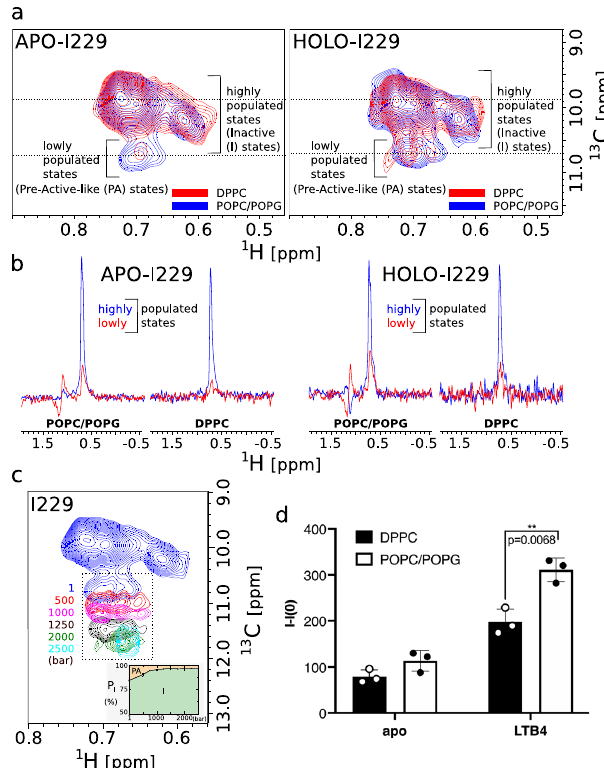
Fig. 6 Impact of the lipid phase on BLT2 activation. a Close-ups in the δ 13 CH 6.40 region of two superimposed 1 H, 13 C SOFAST-HMQC 3 - 1 -I229 experiments were recorded at atmospheric pressure with apo (left) and holo (right) BLT2 in POPC/POPG (in blue) or DPPC (in red) nanodiscs. The dotted lines report on 1 H 1D spectra displayed in b . Spectra were scaled to the most intense cross peak in the two spectra. b Extracted rows in the 1 H dimension from spectra displayed in a . The dispersive signal ~1 ppm corresponds to T 1 noise from the intense signal of lipid methylene protons. c Barotropic evolution of 13 CH 3 - δ 1 -I229 6.40 pre-active-like ( PA ) NMR signals of apo BLT2 in POPC/POPG nanodiscs. For clarity, only the lowly populated conformations are represented for pressures above 1 bar. The inset below spectra represents the relative proportion of I229 inactive ( I ) vs. PA states along the pressure ramp. d Binding of GTP γ S to G α i βγ catalyzed by BLT2-containing nanodiscs at atmospheric pressure in the absence or presence of LTB4. Data are presented as raw fl uorescence intensity under a given condition (I) minus measurement under the same condition for the G protein but in the absence of any particle (I(0)) as mean ± stdev of three experiments. Statistical values were obtained by means of unpaired Student ’ s t test (*0.01 < p < 0.05, **0.001 < p < 0.01). Source data are provided as a Source Data fi